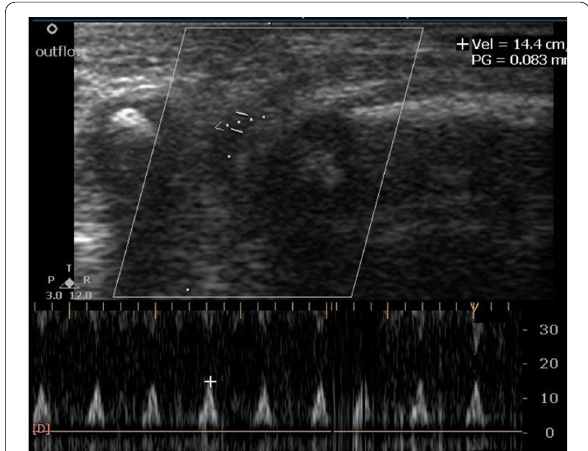
Fig. 5 Radial artery CDU in steal